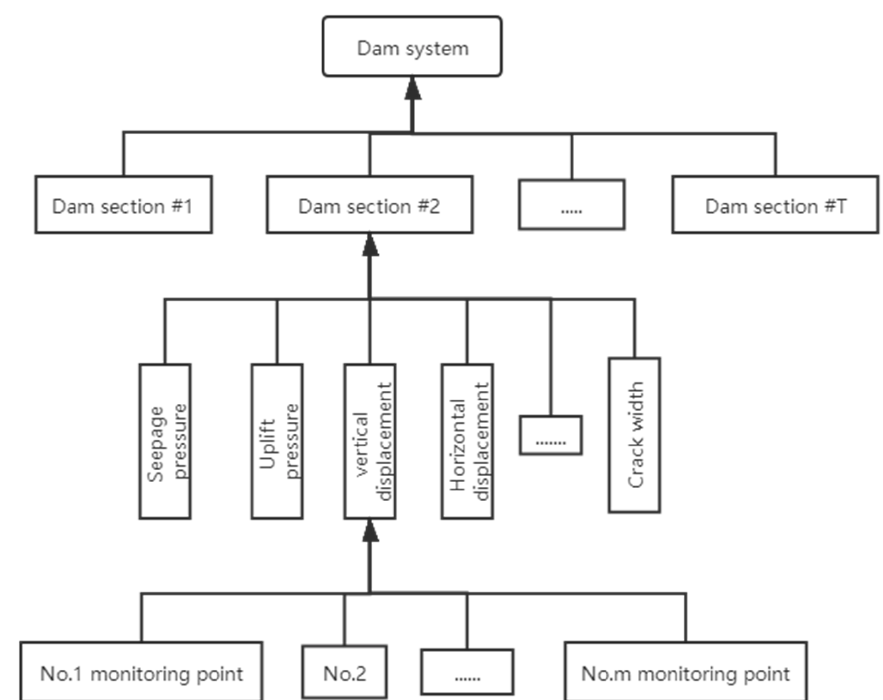
Figure 1. The framework of dam safety assessment.